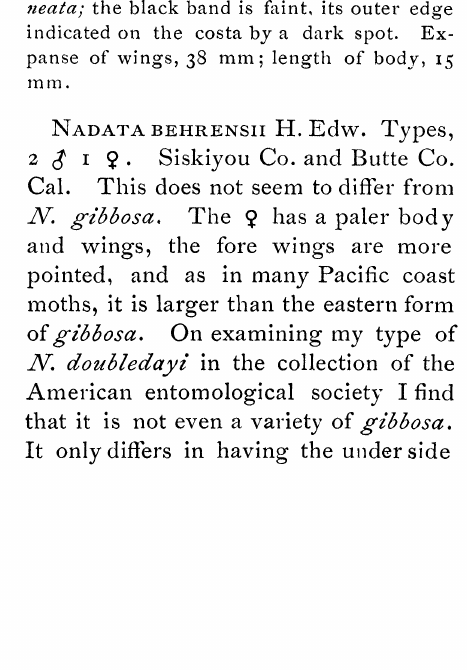
G WRIGI-ITII VAR. SLOSSONAE.Body and wings pale ash-gray the prothoracic segment colored as the head, but the rest of the thorax is dark brown, the median thoracic tuft also dark brown. Fore wings black-brown on basal one-fifth; this portion sending out five sharp tooth-like projections along the sub. costal, submedian and internal veins. regular lobulate edges, and widening on the costa; it encloses a very distinct discal triarr- gular white spot, the apex pointing outwards. A subtnarginal broken row of dark spots arranged much as in Glupkisia trilineata. Hind wings with no markings, but at the inner angle is a faint short curved dark band, edged externally with white, but not reaching beyond the middle of the submedian space. Fringe concolovous with the wing, but checkered with small black